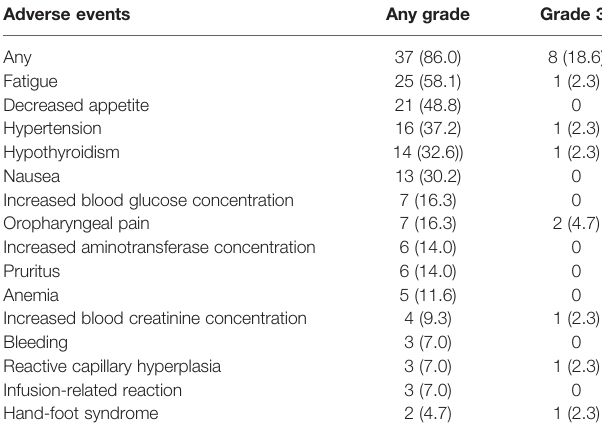
TABLE 2 | Treatment-Related Adverse Events in all patients (n =